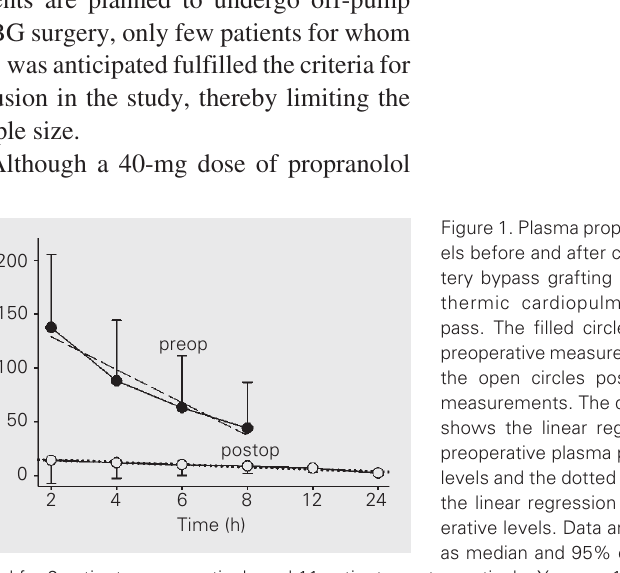
interval for 9 patients preoperatively and 11 patients postoperatively. Y preop = 129 - 30.1x;